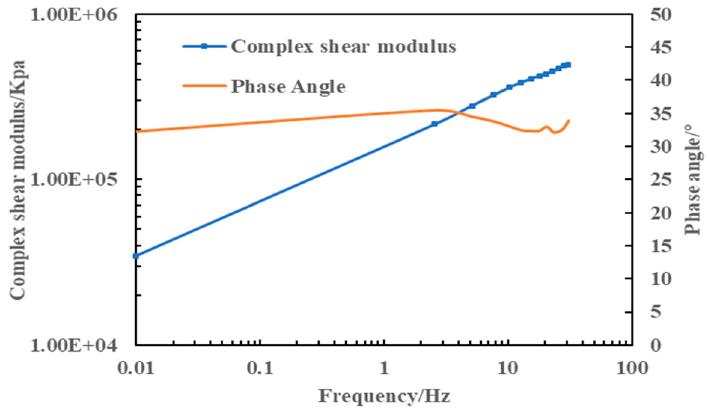
Figure 2. Complex shear modulus and phase angle from frequency sweep test.